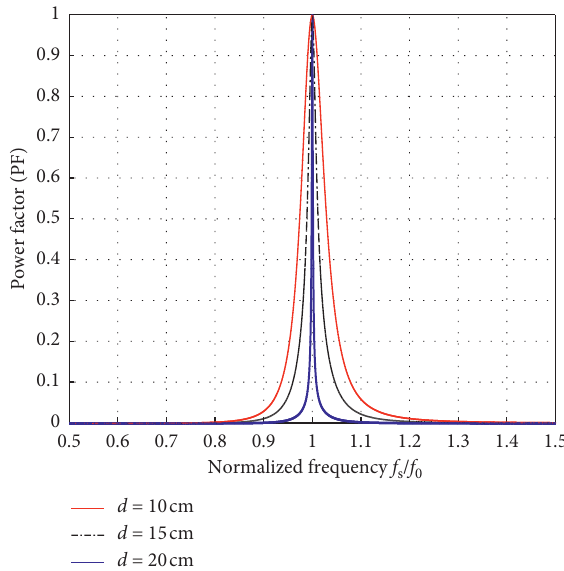
Figure 6: Power factor (PF) as a function of the normalized frequency ( F N � f s / f 0 ) with different air gap values ( f 0 � 10kHz, R p � 1.15 Ω , R s � 0.78 Ω , L p � 4.7 mH, L s � 2.9mH, C p � 55 ɳ F, C s � 88 η F, R e � 20 Ω